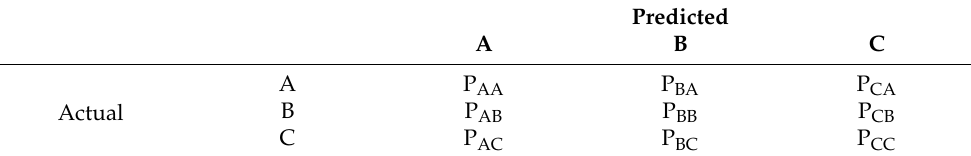
Table 1. Visualization of the confusion